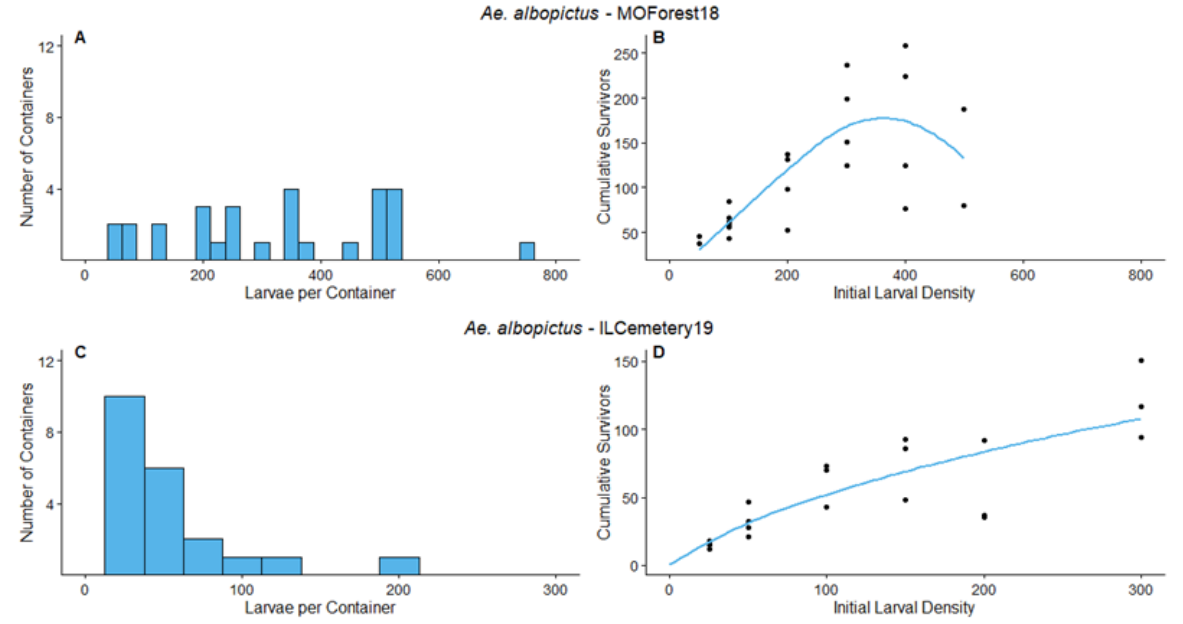
Figure 3. Results for MOForest18 and ILCemetery19 experiments. The left panels are the frequency distribution of mosquito larvae per container at the end of the survey periods, ( A ) for MOForest18, ( C ) for ILCemetery19. The points on the right panels represent the cumulative number of survivors of the density manipulation experiments, ( B ) for MOForest18, ( D ) for ILCemetery19. The lines on the right panel represent the predicted values for the relationship between initial larval density and cumulative survivors, according to the non-linear regression analyses. Blue indicates that the experiment was conducted on Ae. albopictus .